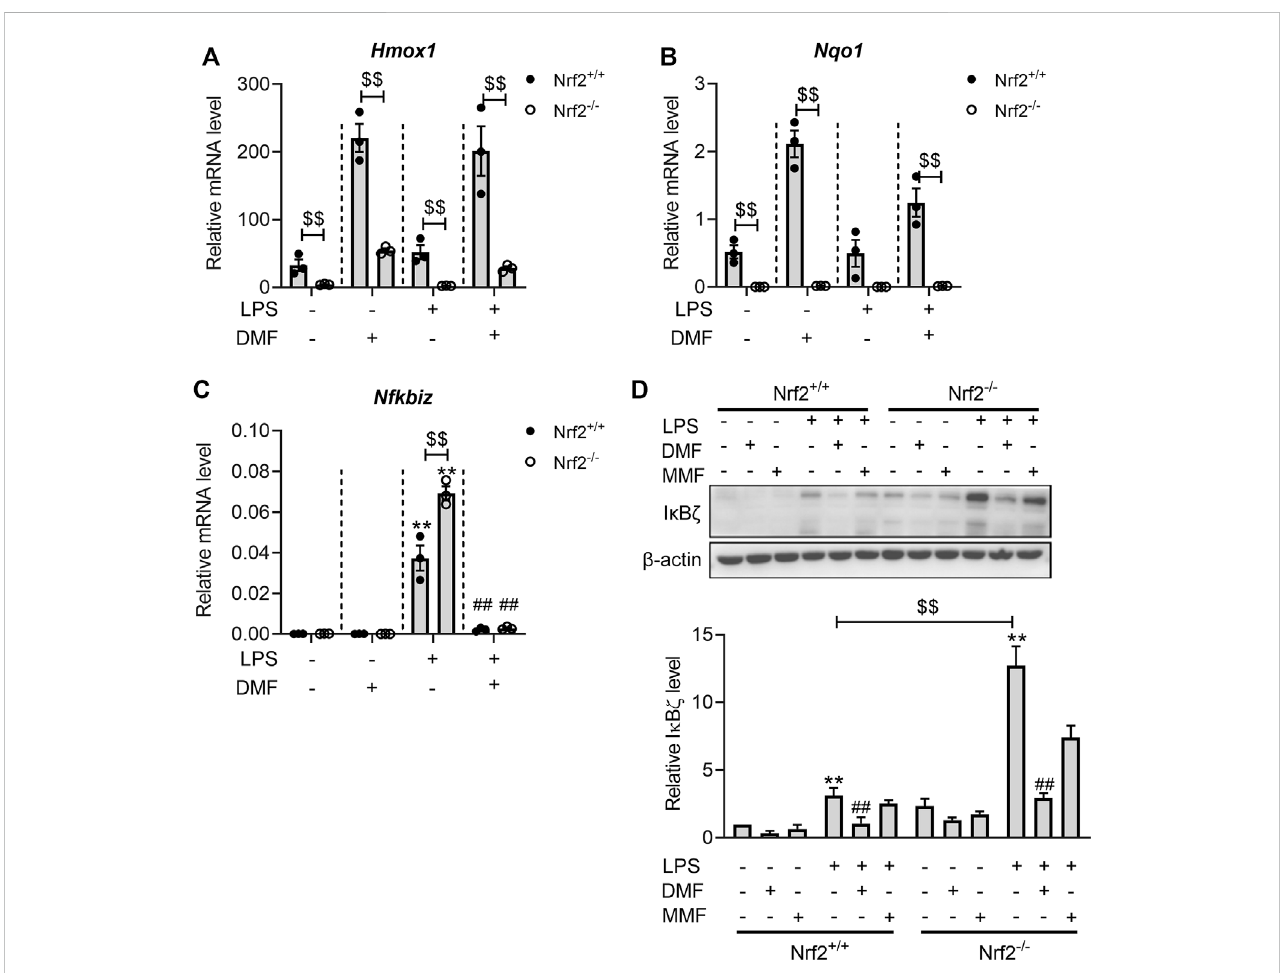
FIGURE 7 DMFinhibitedLPS-inducedI κ B ζ expressioninbothNrf2 +/+ andNrf2 − / − BMDMs. (A,B) Nrf2 +/+ orNrf2 − / − BMDMsweretreatedwith40 μ MDMF/MMFfor1 h and then stimulated with 1 μ g/mL LPS in the absence of DMF/MMF for 6 h. RT ‒ qPCR analysis of Hmox1 (A) and Nqo1 (B) mRNA expression in the indicated groups ( n = 3). (C,D) Nrf2 +/+ or Nrf2 − / − BMDMs were treated with 40 μ M DMF/MMF for 1 h and then stimulated with 1 μ g/mL LPS in the absence of DMF/MMF for1 h (C) RT ‒ qPCRanalysisof Nfkbiz mRNAexpressionintheindicatedgroups( n =3). (D) westernblotanalysisandquanti fi cationoftheI κ B ζ expression level ( n =3).** p < 0.01 vs.theuntreatedgroupbyone-way ANOVA. ## p < 0.01 vs.theLPS groupbyone-wayANOVA. $$ p < 0.01 vs.theNrf2 − / − groupby t